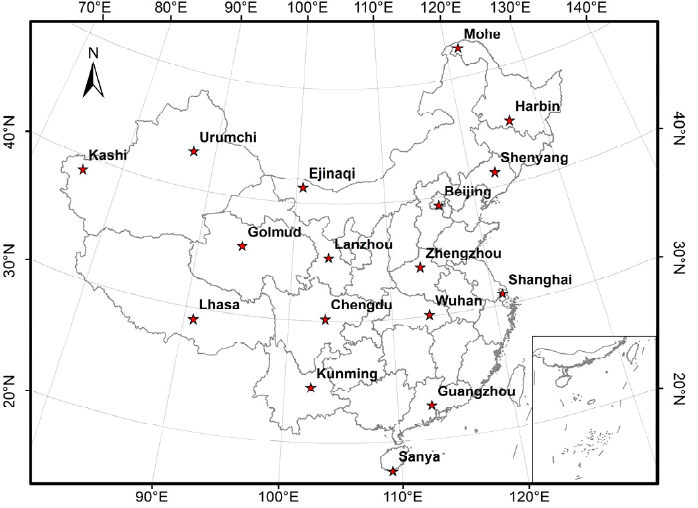
Figure 1. Distribution of 17 CMA diffuse solar radiation stations used in this study.